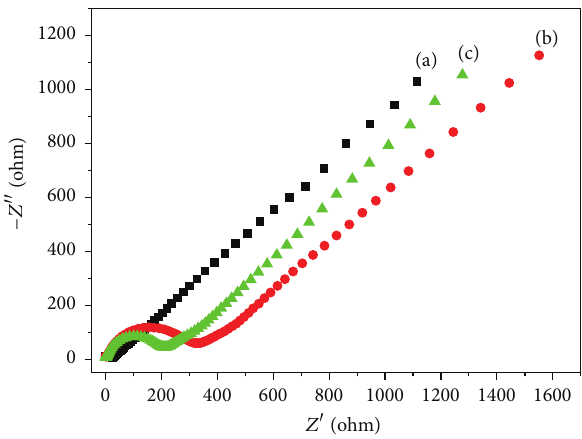
Figure 4: EIS of modified electrodes: (a) bare GCE, (b) PDA- Lac/GCE, and (c) PDA-Lac-rGO-Pd/GCE in 0.1M KCl containing 5 mM Fe ( CN ) 63−/4− . Frequency range: 0.01 Hz–100000 Hz. Ampli- tude: